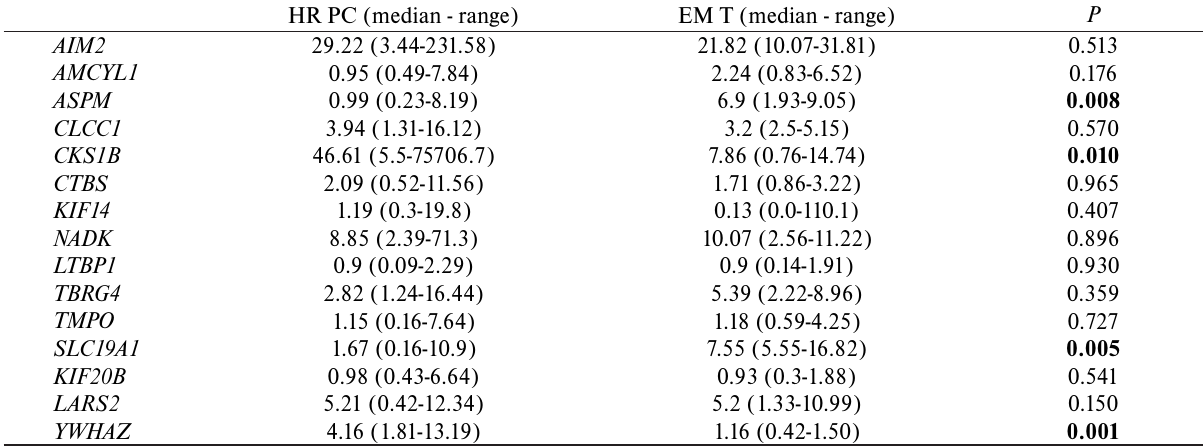
Table 3b. Comparison of gene expression between HR PC and EM T groups.